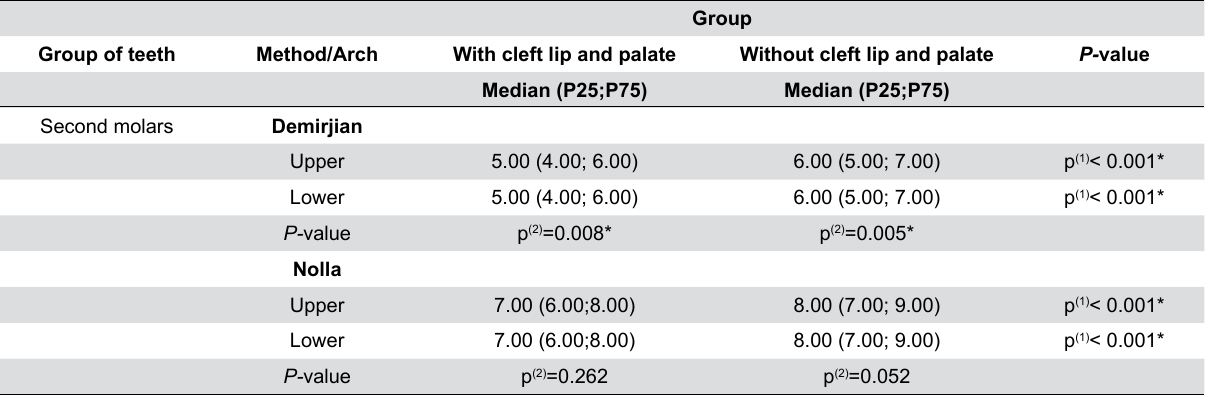
Table 4- Analysis of the development stages of permanent second molars in individuals with or without cleft lip and palate, according to arch (maxilla or mandible), using Wilcoxon’s test for paired